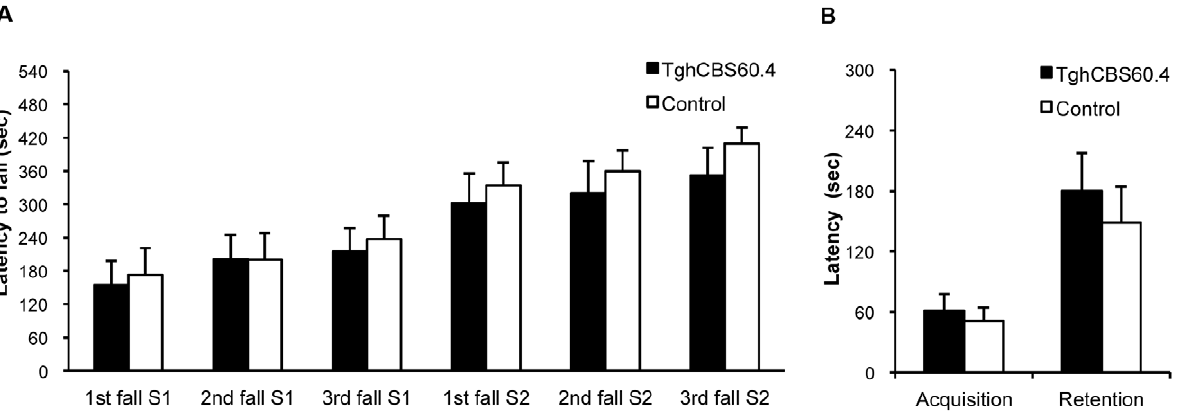
Figure 6. Behavioral assessments in Tg hCBS 60.4 mice. The analysis was conducted on 8 Tg hCBS 60.4 and 8 control mice. Data represent mean + S.E.M. for each group. (A) Rotarod test: latencies of first fall, second fall and third fall recorded in the 10 min accelerating periods of the two rotarod sessions (S1, S2) are presented. (B) Passive avoidance test: latency to enter into the dark compartment in acquisition session and in retention session was